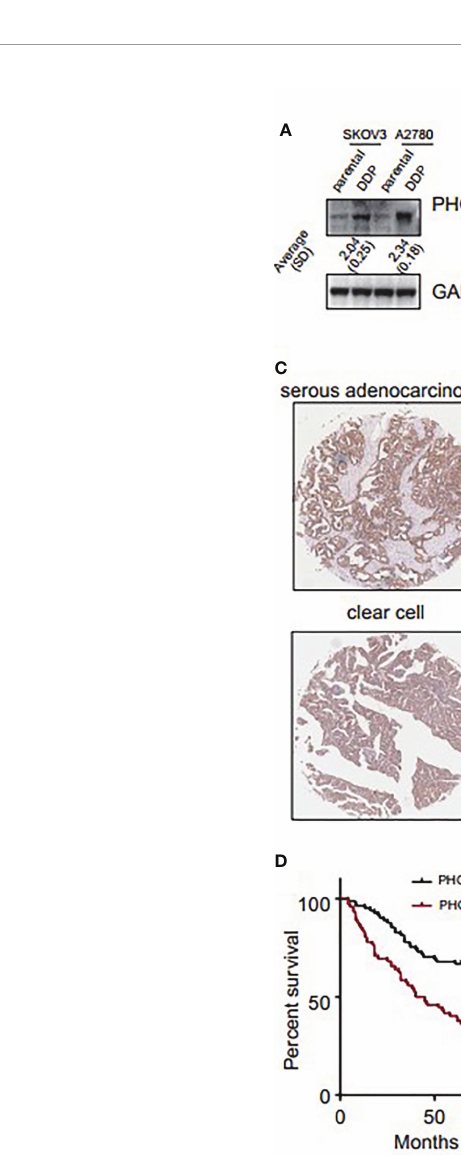
FIGURE 1 | PHGDH is increased in platin-resistant ovarian cancer and predicts poor prognosis of patients with ovarian cancer. (A) PHGDH expression was assessed using Western blot in platin-sensitive (parental) and their platin-resistant (DDP) SKOV3 and A2780 cells. The relative expression was noted under the blots. (B) PHGDH expression was investigated in 16 cisplatin-sensitive and nine cisplatin-resistant ovarian cancer tissues using Western blot. (C) Ovarian cancer tissue microarray was subjected to immunohistochemical staining, and representative images of immunohistochemistry staining with PHGDH were presented. (D) Kalpan – Meier plot shows the overall survival of patients with ovarian cancer grouped by PHGDH